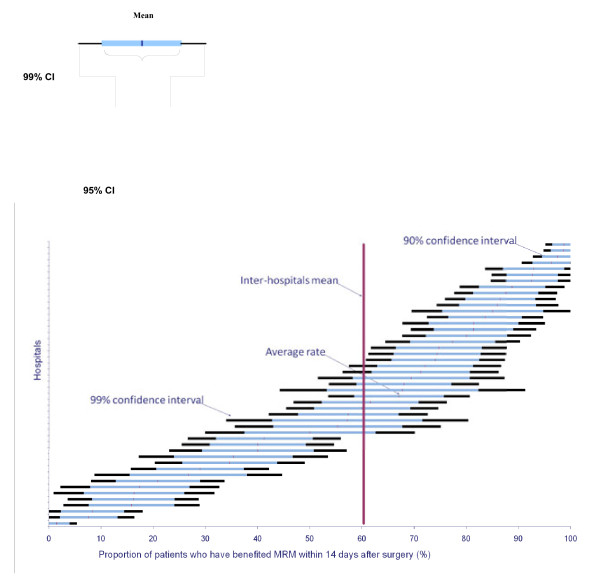
Comparison among hospitals using QI 3. (Proportion of patients undergoing postoperative MDTM 14 days after surgery). The result for each hospital (anonymous on the ordinate) is given by a horizontal line that represents confidence intervals (CI) (90 % CI - blue; 99 % CI - black). The vertical line gives the overall mean score for all hospitals and is used for benchmarking.